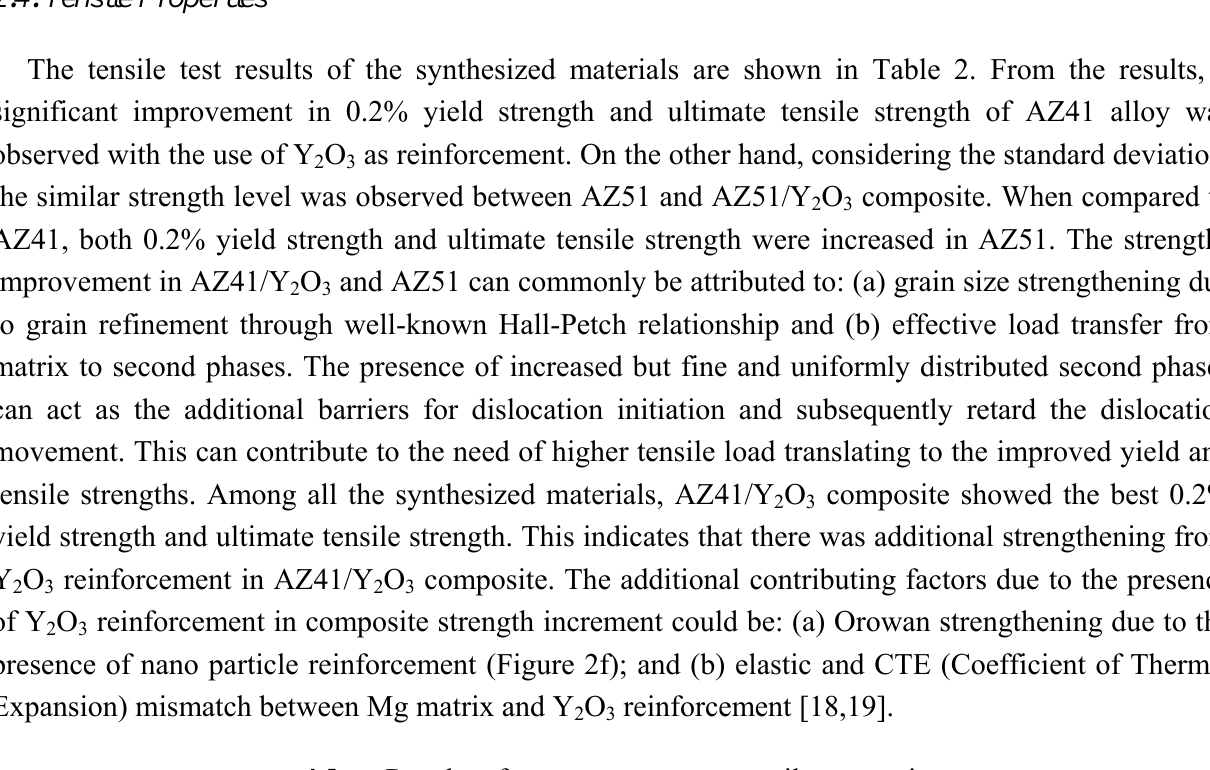
Table 2. Results of room temperature tensile